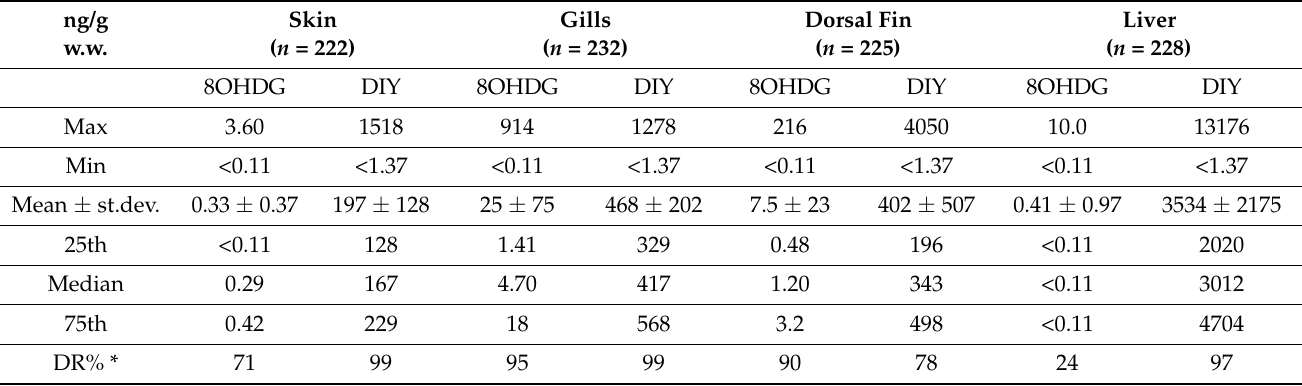
Table 3. Concentrations of 8OHDG and DIY in skin, gill, dorsal fin, and liver tissue samples from Atlantic salmon